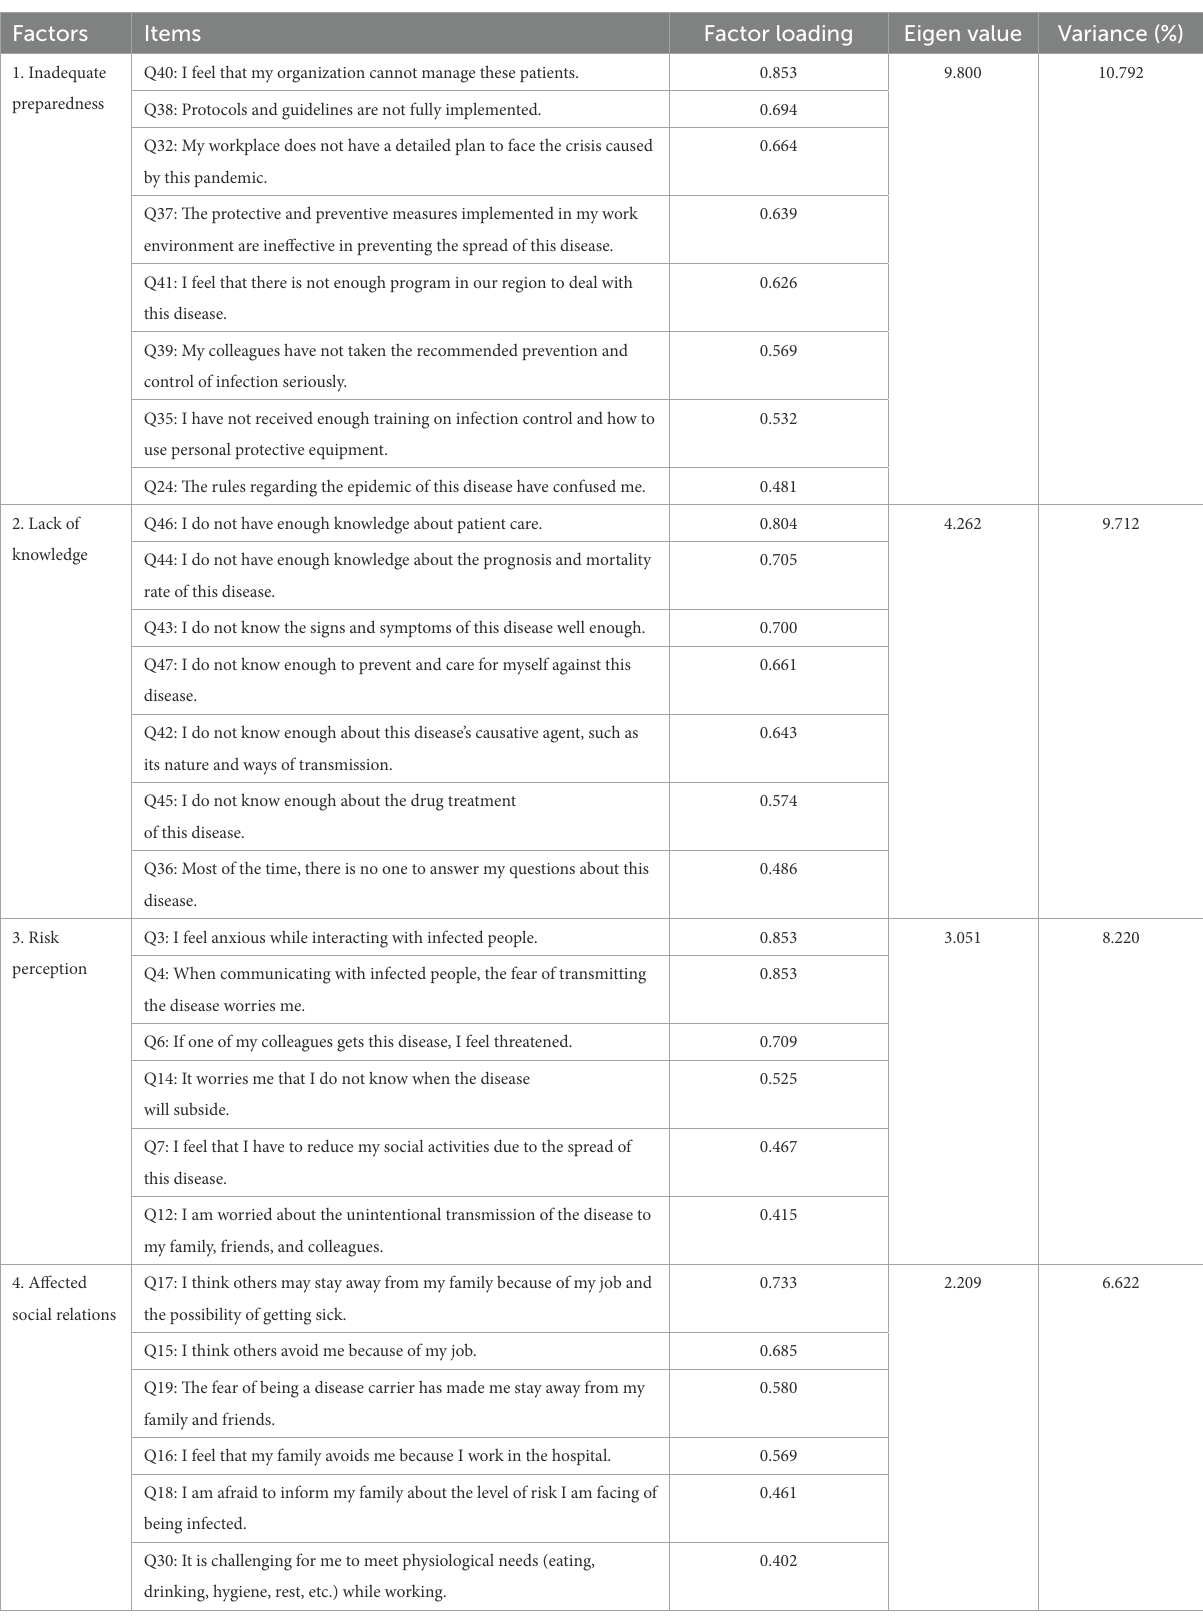
TABLE 2 Exploratory factor analysis of